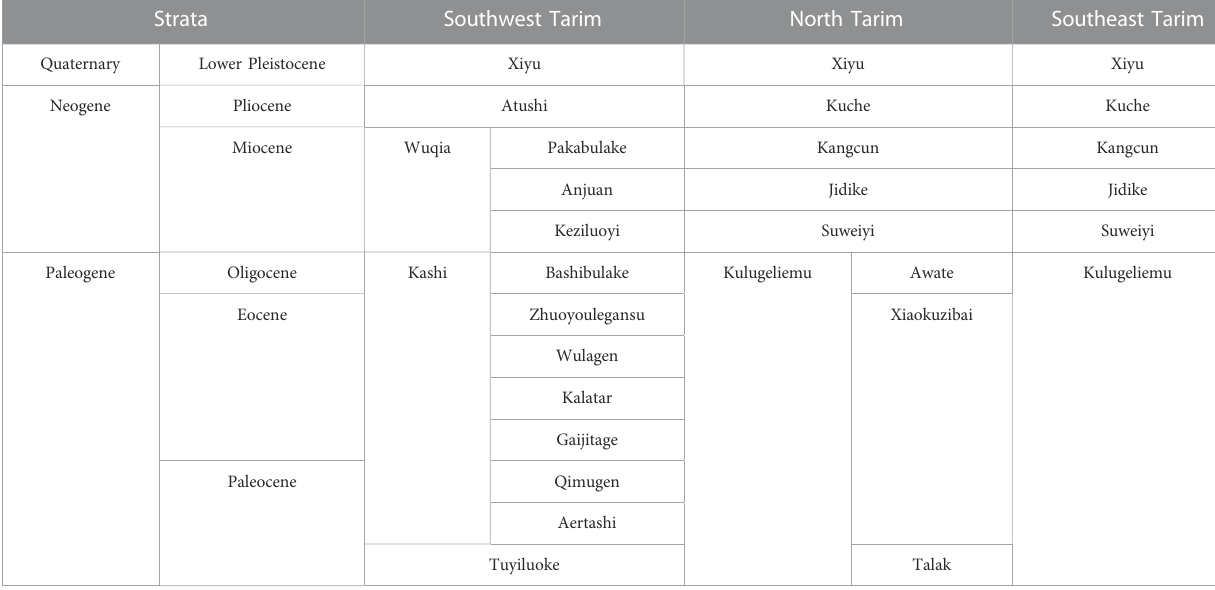
TABLE 1 Cenozoic stratum in the Tarim Basin (Ding et al., 1993; 2011; Guo, 1994; Jia et al., 2004; Shao et al., 2006; Li et al., 2017).